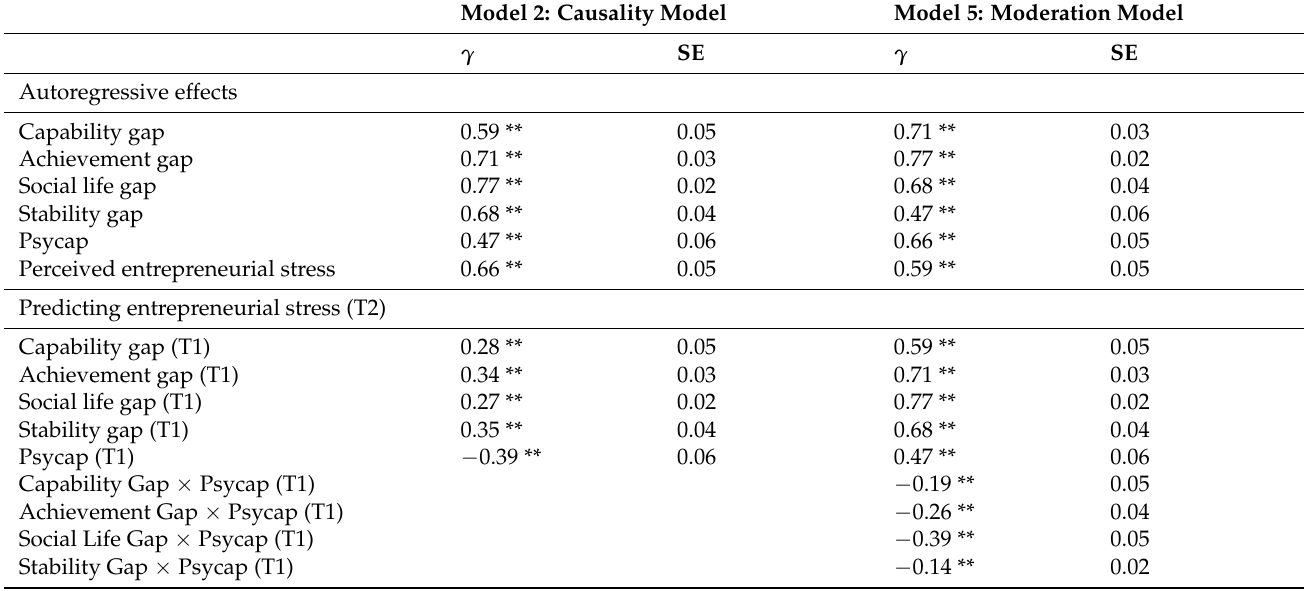
Table 6. Parameter estimates of the path